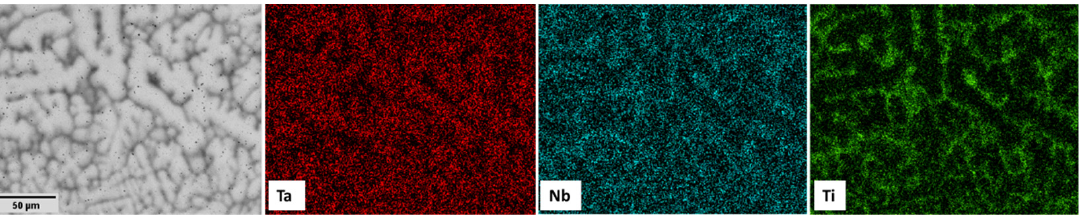
Figure 4. EDS mappings of alloy Ta-Nb-Ti.